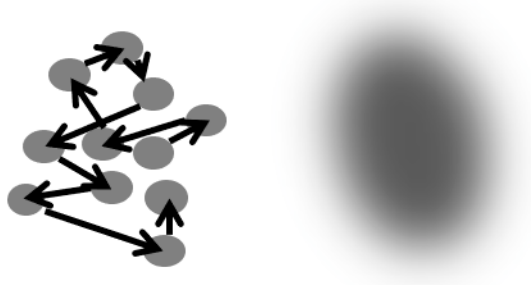
Figure 1. The “zitter” of an electron (left) and a time-averaged view of it (on the right). Time-averaging is an incomplete model simplification: It introduces an unrealistic explosion